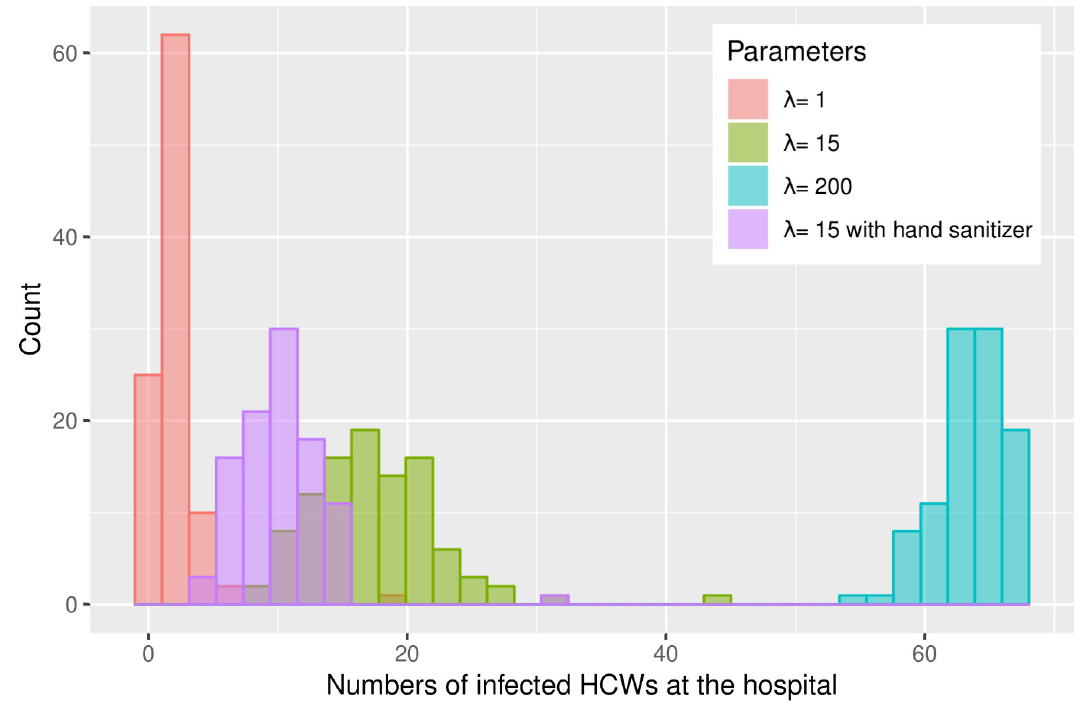
Fig 7. Histogram over the number of infected and the frequency over 100 simulations at the hospital.